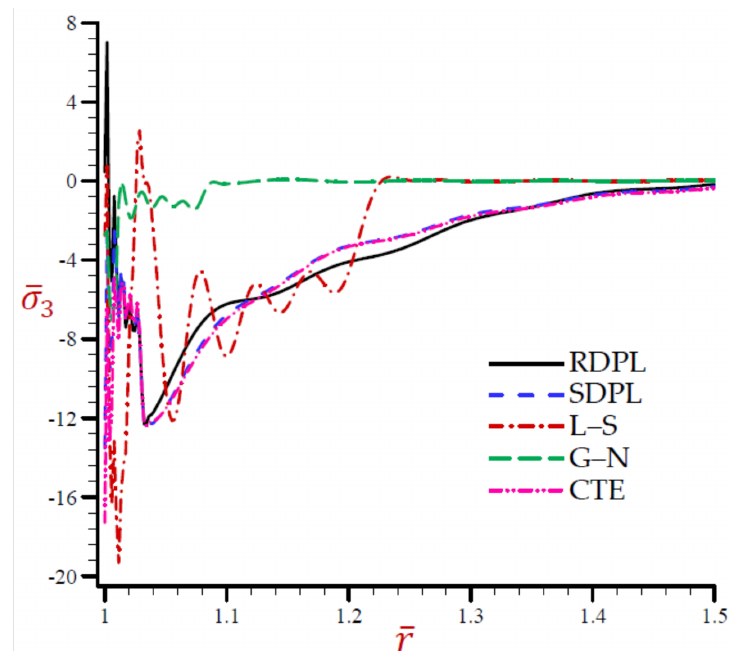
Figure 6. The axial stress σ 3 across the radial direction of the cylindrical cavity conferring to all theories.